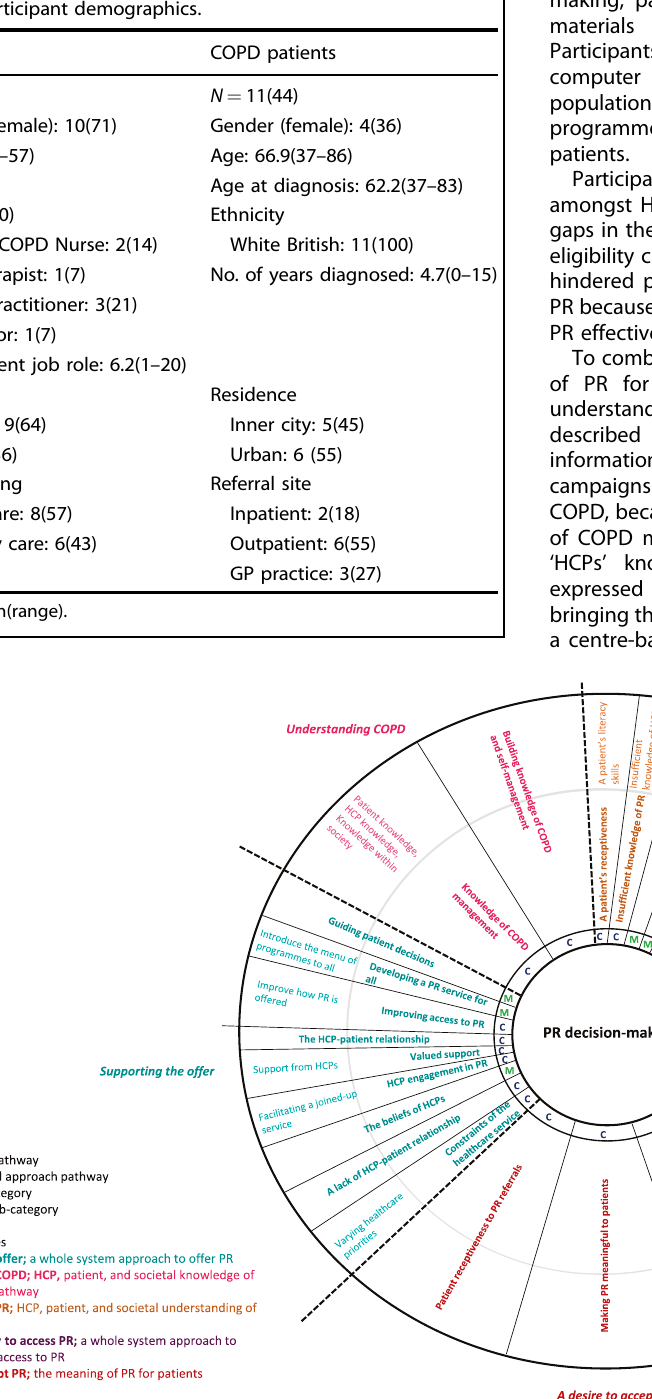
Fig. 1 A thematic map of the generated categories and sub-categories, displayed by high-level theme.